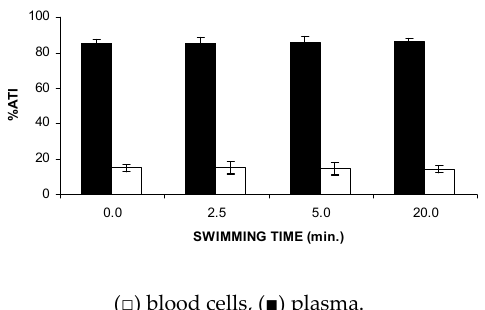
Figure 3. Effect of the forced swimming (FS) on the distribution of 99m Tc between the cellular and plasma compartments. Wistar rats were submitted to FS, blood samples were withdrawn, and the labeling of blood constituents with 99mTc procedure was carried out. Blood cells and plasma were separated by centrifugation. The radioactivity in blood cells and plasma was measured and the percentage of 99m Tc incorporated (%ATI) was calculated.